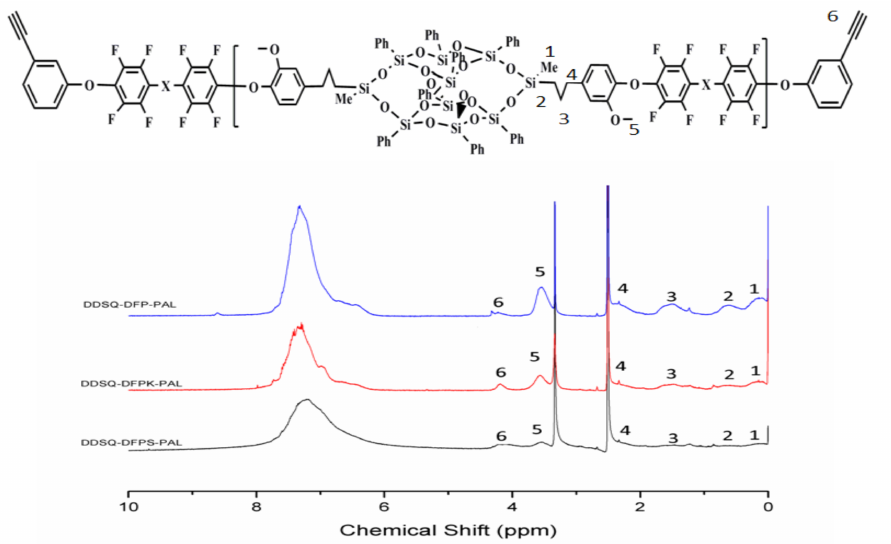
Figure 5. 1 H NMR spectra of phenylacetylene-terminated DDSQ-DFPXs-PAL in DMSO-d 6 .